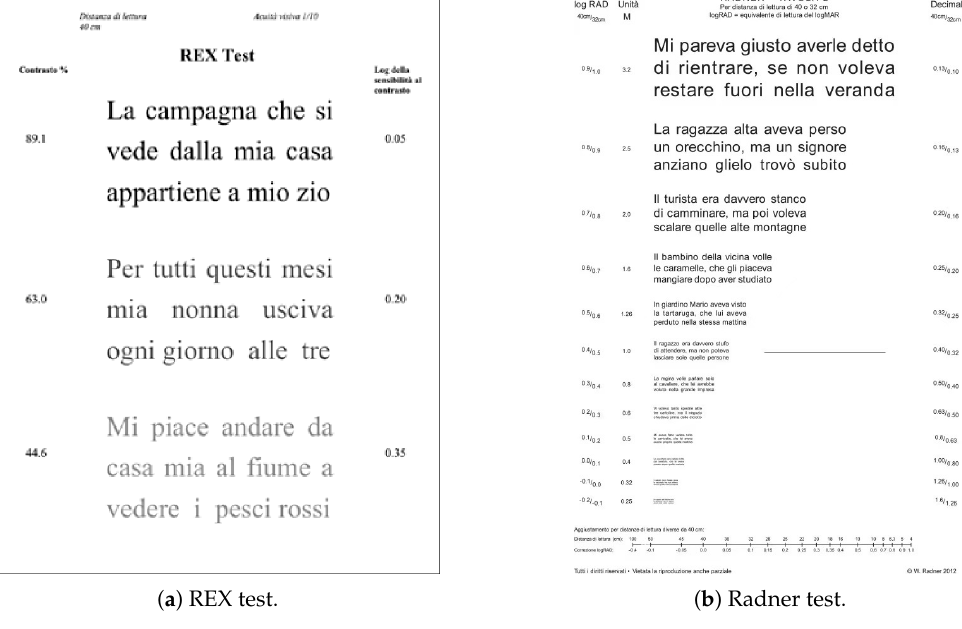
Figure 3. The reading